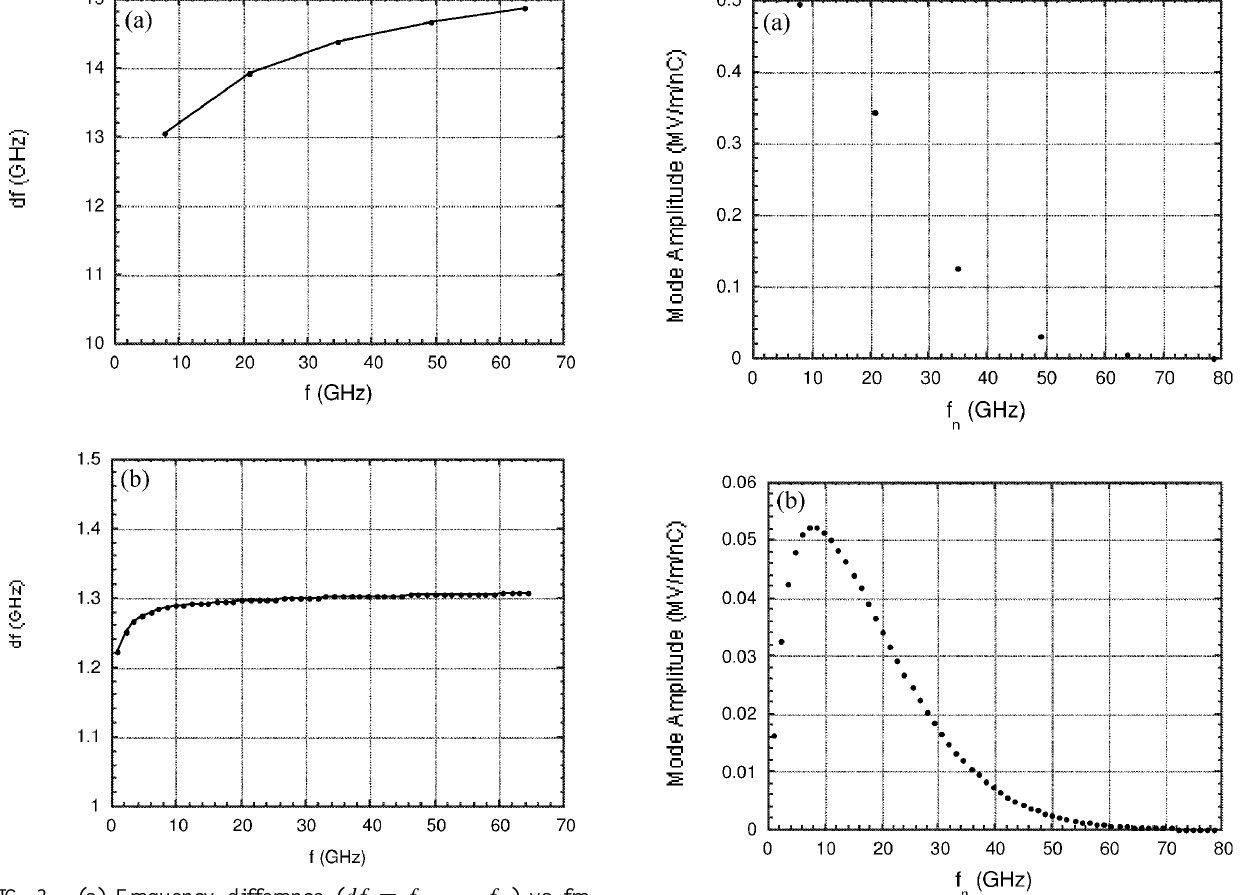
FIG. 3. (a) Frequency difference ( df (cid:1) f n 1 1 2 f n ) vs fre- quency ( f n ) for the single-mode structure. Note that df varies from (cid:6) 13 GHz for n (cid:1) 1 to (cid:6) 15 GHz for n (cid:1) 5 . (b) Fre- quency difference ( df (cid:1) f n 1 1 2 f n ) vs frequency ( f n ) for the multimode structure. Note that df varies from (cid:6) 1.2 GHz for n (cid:1) 1 to 1.3 GHz for n (cid:1) 50 .